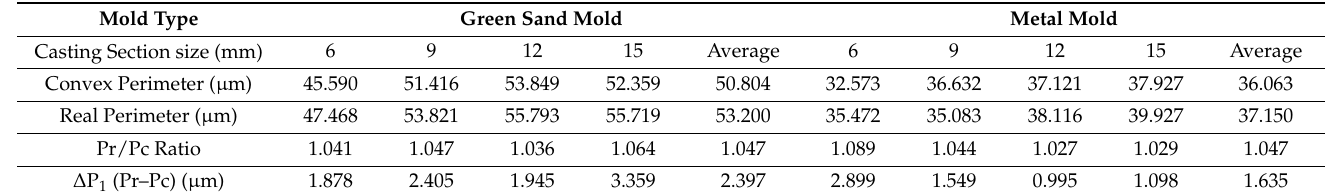
Table 2. Convex and real graphite particles perimeter in wedge castings solidified in green sand and metal molds.